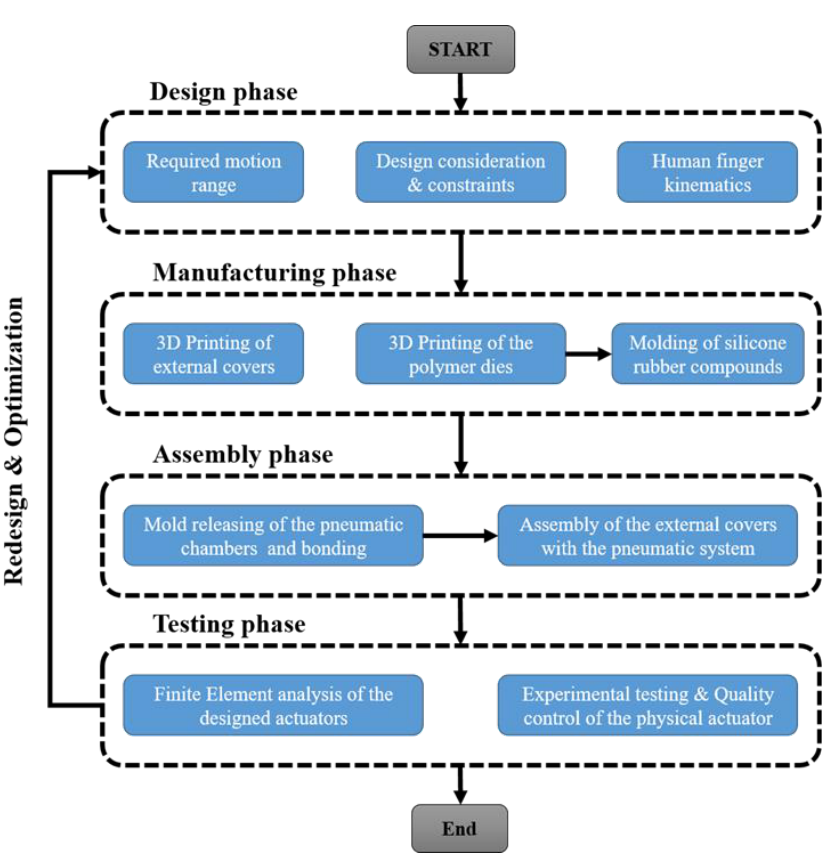
Figure 1. Flowchart for the production of the developed actuator.